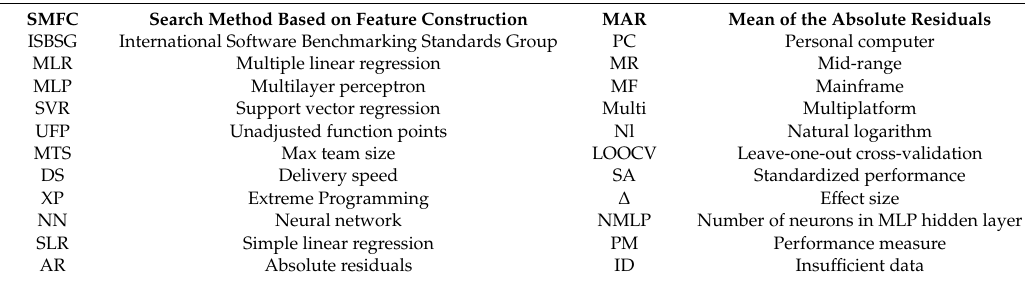
Table 4. Table of